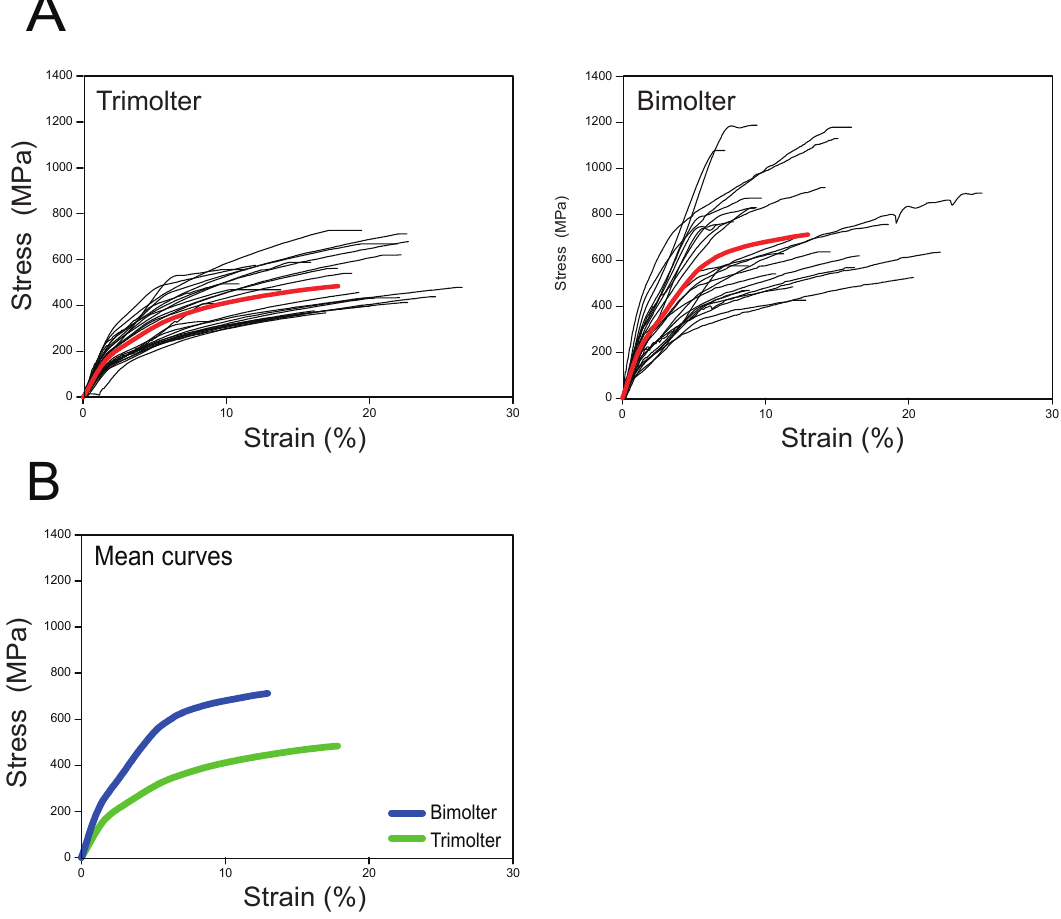
Figure 8. Tensile stress–strain curves. ( A ) Stress–strain curves of silk fibers from each group ( n = 25). The bold red curve represents the mean curve from each group. ( B ) Comparison of the mean curves of the trimolter silk (green) and bimolter silk